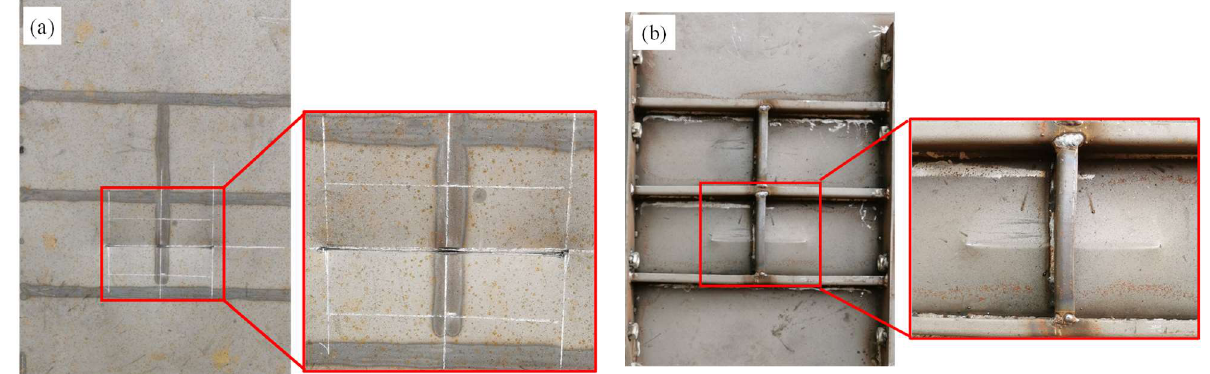
Figure 14. Deformation of the strengthened plate under eccentric impact: ( a ) front side; ( b ) back side.